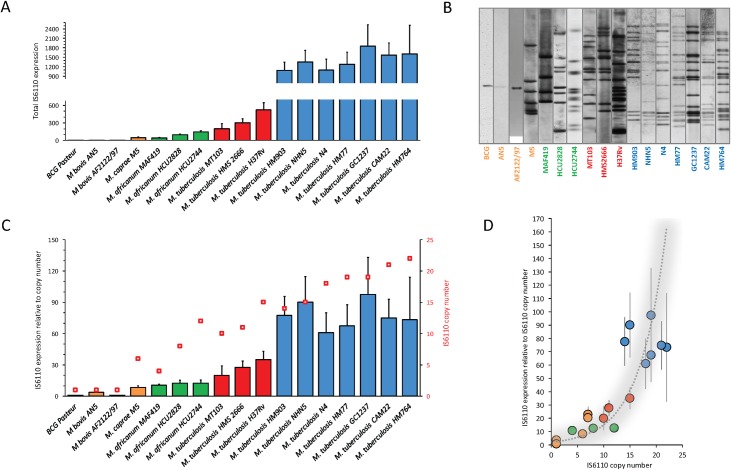
IS6110 gene expression and determination of transposition dynamics in the MTBC.(a) Total IS6110 expression in representative strains from the MTBC. Data are relative to BCG Pasteur. Columns and error bars are the average and standard deviation from three independent cultures. (b) IS6110 RFLP from MTBC strains analysed in panel (a). (c) IS6110 expression values normalised to the copy number content of this element. Columns represent normalised expression of IS6110 according to the left Y-axis. Red squares show the IS6110 copy number in each strain indicated in the right Y-axis. Normalised expression of BCG Pasteur is used as reference. (d) Expression per IS6110 copy relative to the copy number content in MTBC strains. Data fit with an exponential curve (r2 = 0.80) indicated by a grey shadowed line.